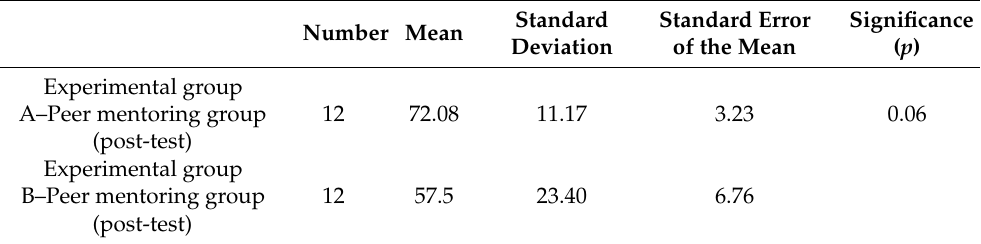
Table 10. Post-test t -test analyses of Experimental group A-peer mentoring group and Experimental group B-peer mentoring group.